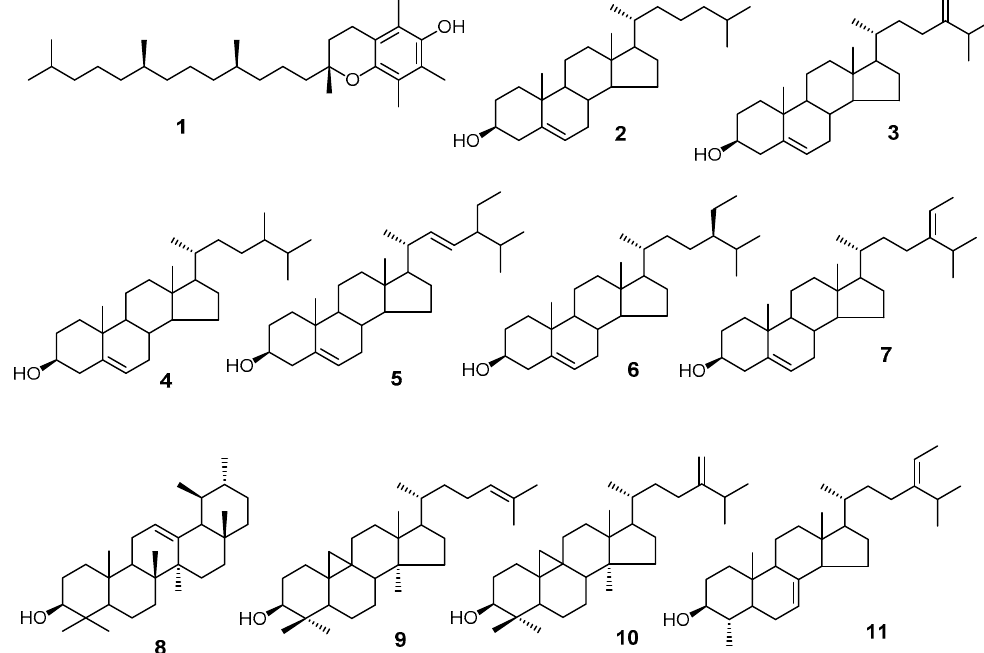
Figure 1. Structures of compounds identified by GC/MS. The structures are 1 . α -tocopherol; 2 . cholesterol; 3 . 24-methylenecholesterol; 4 . campesterol; 5 . stigmasterol; 6 . sitosterol; 7 . isofucosterol; 8 . α